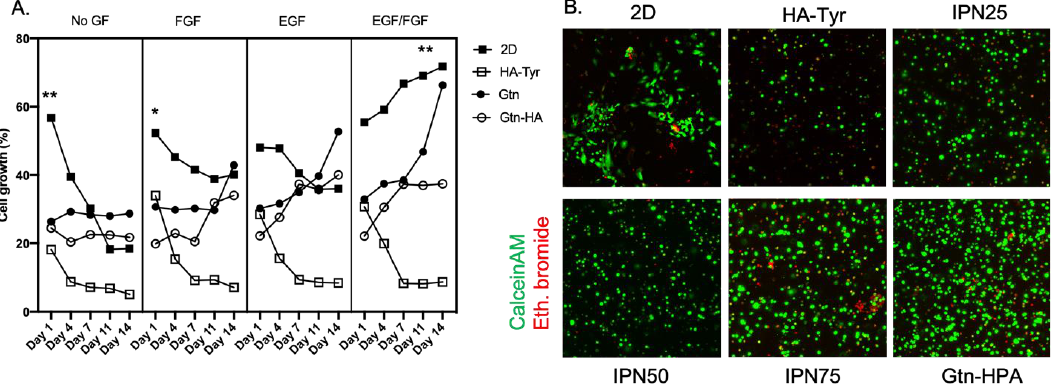
Figure 4. Viability and proliferation assay for hRPCs encapsulated in IPNs. ( A ) Cell growth was obtained with Alamar Blue staining for n = 5 replicates using colorimetry. Cells were found to possess a significantly higher growth when encapsulated in pure Gtn-HPA or with media. (* p < 0.05, ** p < 0.005). ( B ) Live/dead staining of hRPCs in different tissue culture conditions. Gtn-HPA shows the highest number of live cells while HA-Tyr shows highest number of dead cells.